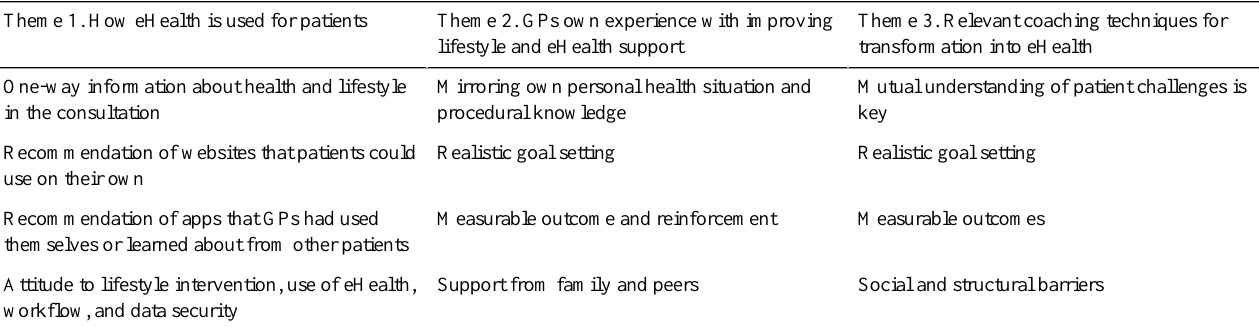
Table 2. Themes and subthemes for general practitioners’(GP) perception of electronic health (eHealth) in relation to lifestyle improvement.